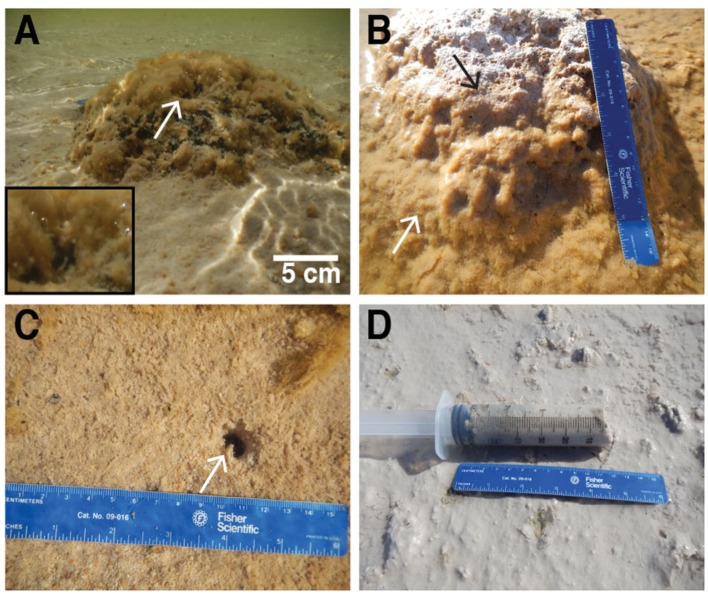
Microbial mats in Lake Clifton, Western Australia.
(A) Thrombolite-associated microbial mat with oxygen bubbles (inset box shows higher magnification) observed emanating from the mat surface. White arrow denotes lower left corner of inset box. (B) Thrombolite-associated microbial mat (white arrow) grades upward into a desiccated mat (black arrow) consistent in appearance with lithified thrombolites. (C) Sediment-associated microbial mat forming on sandy lakebed sediments. (D) Sediment-associated microbial mat with a strong sulfide smell observed during sampling. Length of blue ruler = 16 cm. Arrows are also representative of sampling locations.